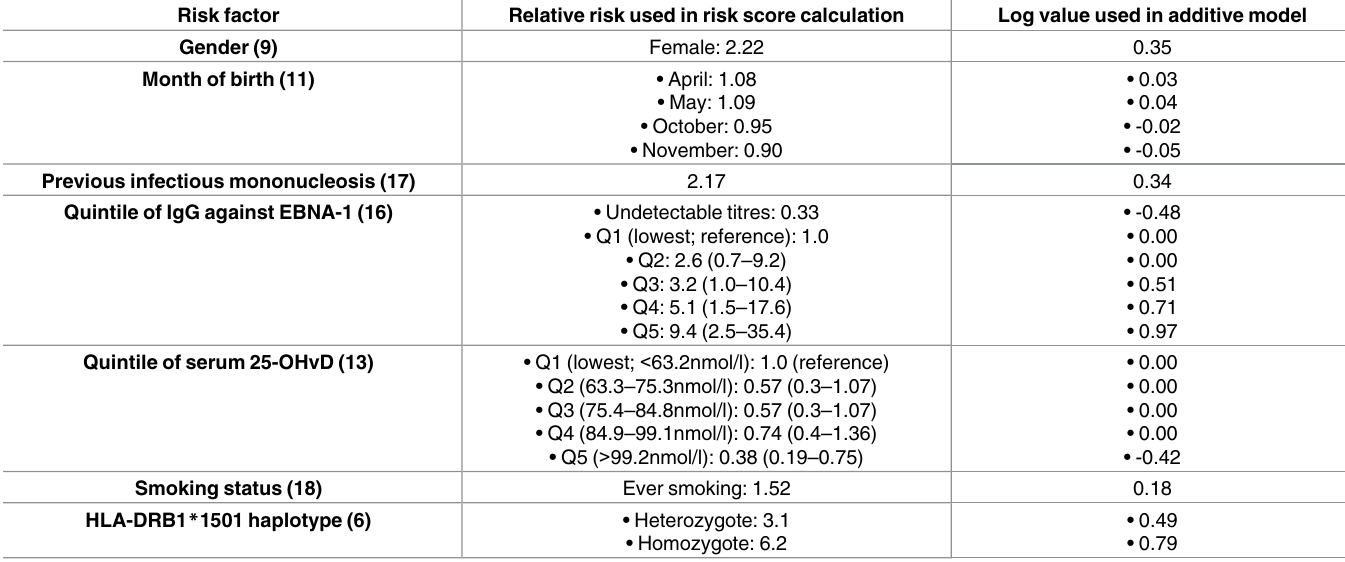
Table 2. Summaryof relative risks used in the calculation of an overall risk score. The risk associatedwith carriageof the HLA-DRB1 * 1501haplotype is given; for the risks associated with other HLA haplotypesand non-MHC SNPs see appendix 1. Risk factor Relative risk used in risk score calculation Log value used in additive